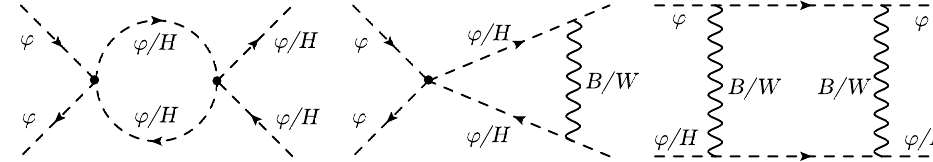
Figure 2. Sample one-loop Feynman diagrams for the calculation of the quartic scalar coupling and the Higgs-portal